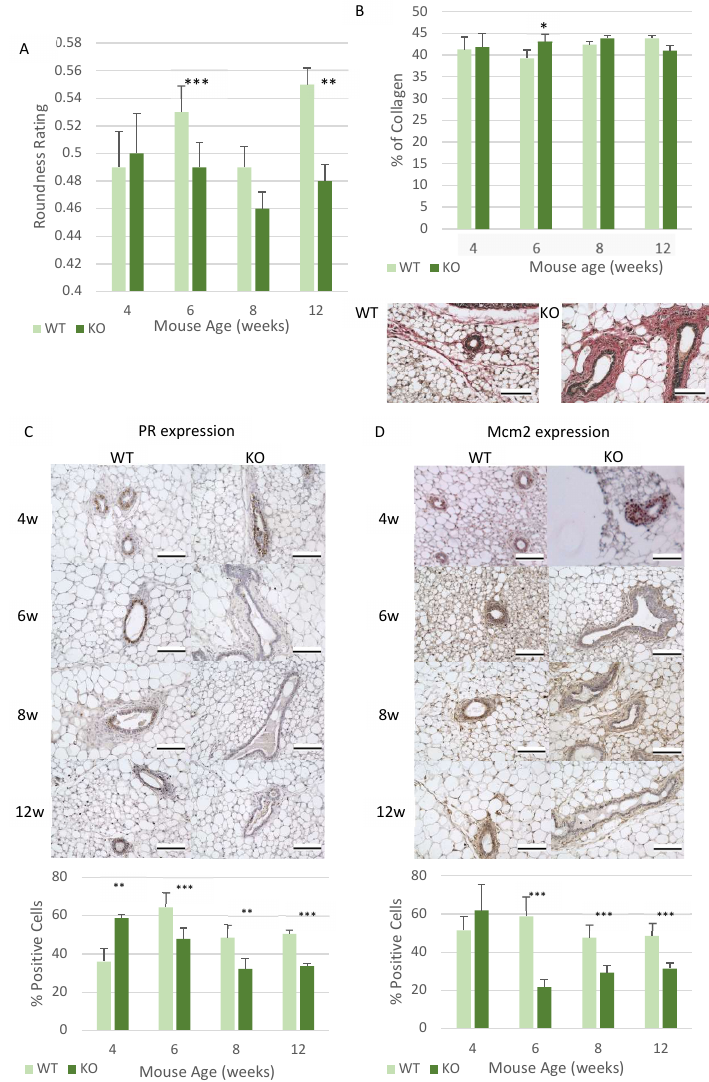
Figure 4. Loss of Csmd1 is able to promote changes in ductal morphology and development factors. ( A ) Graph showing changes in duct roundness, the lumen of the ducts were measured and then analysed using ImageJ software. The roundness rating is between 0 and 1, with 1 being a perfect circle (** p < 0.01 and *** p < 0.001). The numbers of animals for each time point included 4-week-old mice ( n = 6 WT; n = 6 KO), 6-week-old mice ( n = 8 WT; n = 7 KO), 8-week-old mice ( n = 7 WT; n = 7 KO), 12-week-old mice ( n = 7 WT; n = 7 KO). ( B ) Analysis of the Picro-Sirus Red staining, which is used to stain collagen red. The staining is shown in the images below the graph which depicts ducts at 6 weeks of age in the WT and KO mice, with the red collagen staining located around each duct. The graph shows the percentage of collagen surrounding each duct, which was calculated using ImageJ (* p < 0.05) ( n = 6 WT; n = 6 KO), 6-week-old mice ( n = 8 WT; n = 7 KO), 8-week-old mice ( n = 7 WT; n = 7 KO), 12-week-old mice ( n = 7 WT; n = 7 KO) ( C ) The analysis of progesterone receptor (PR) expression, the images show respective examples of the ducts at each time point in both the WT and KO mice. The graph highlights the percentage of cells which positively express PR (** p < 0.01 and *** p < 0.001). The numbers of animals for each time point included ( n = 6 WT; n = 6 KO), 6-week-old mice ( n = 8 WT; n = 7 KO), 8-week-old mice ( n = 7 WT; n = 7 KO), 12-week-old mice ( n = 7 WT; n = 7 KO). ( D ) Analysis of the level of proliferation occurring in each duct in the WT and KO mice. The images show proliferation in the ducts at all ages in both the WT and KO mice, with the graph showing number of cells actively proliferating (*** p < 0.001). The numbers of animals for each time point included 4-week-old mice ( n = 6 WT; n = 6 KO), 6-week-old mice ( n = 8 WT; n = 7 KO), 8-week-old mice ( n = 7 WT; n = 7 KO), 12-week-old mice ( n = 7 WT; n = 7 KO). All images taken using an x40 objective, with all scale bars 100 µ